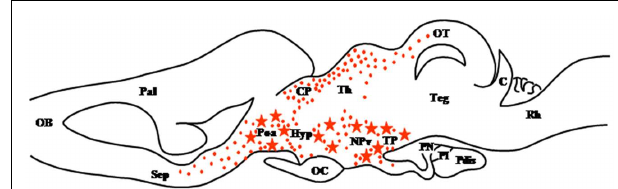
FIGURE 2 | Schematic parasagittal section depicting the distribution of 3 β -hydroxysteroid dehydrogenase (3 β -HSD)-immunoreactive cell bodies (stars) and fibers (dots) in the central nervous system of Rana esculenta (Mensah-Nyagan et al., 1994). The anatomical structures are designated according to the nomenclature of Northcutt and Kicliter (1980) and Neary and Northcutt (1983). C, cerebellum; CP, corpus geniculatum thalamicum; Hyp, hypothalamus; NPv, nucleus of the periventricular organ; OB, olfactory bulb; OC, optic chiasma; OT, optic tectum; Pal, pallium; Poa, anterior preoptic area; Pdis, pars distalis; PI, pars intermedia; PN, pars nervosa; Rh, rhombencephalon; Sep, septum;Teg, tegmental nuclei;TP, posterior